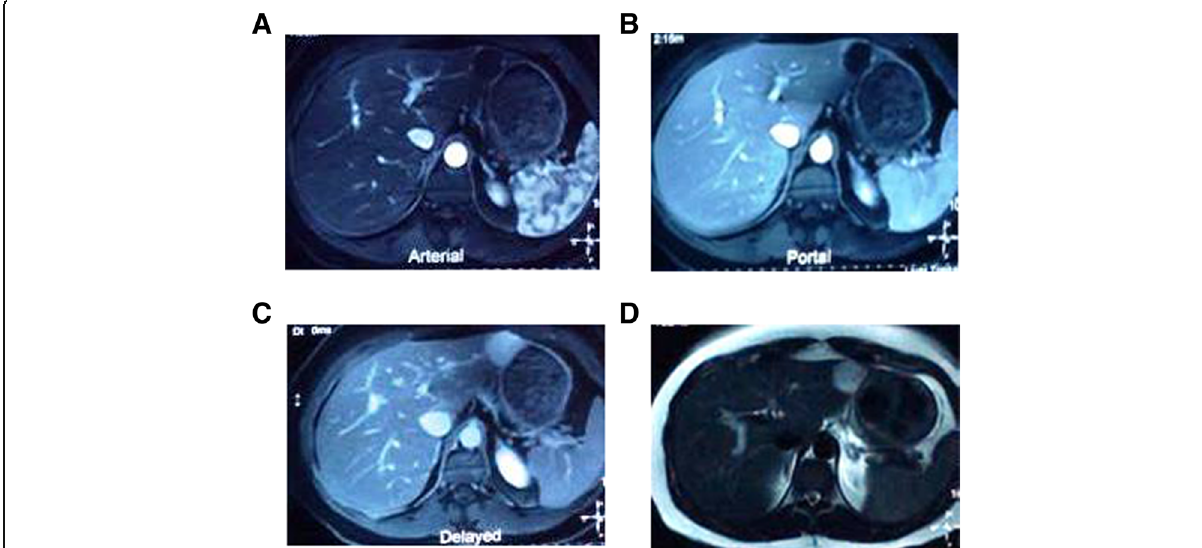
Fig. 3 Axial dynamic MRI sequences of the liver for left lobe 3 cm sub-capsular hemangioma. a Axial T1 arterial phase showing faint peripheral enhancement. b Progressive enhancement at axial T1 portal phase. c Axial T1 delayed phase showing homogenous enhancement of the lesion.